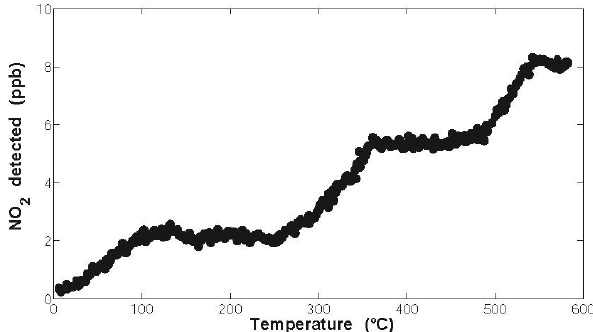
Fig. 3. Temperature scan when the TD-LIF sampled synthetic PAN, Figure 3. Temperature scan when the TD-LIF sampled synthetic PAN, ethyl nitrates and 2 ethyl nitrates and HNO 3 , generated in the laboratory to identify the HNO 3 , generated in the laboratory to identify the temperatures where these compounds are 3 temperatures where these compounds are thermally dissociated into thermally dissociated into NO 2 . 4 NO 2